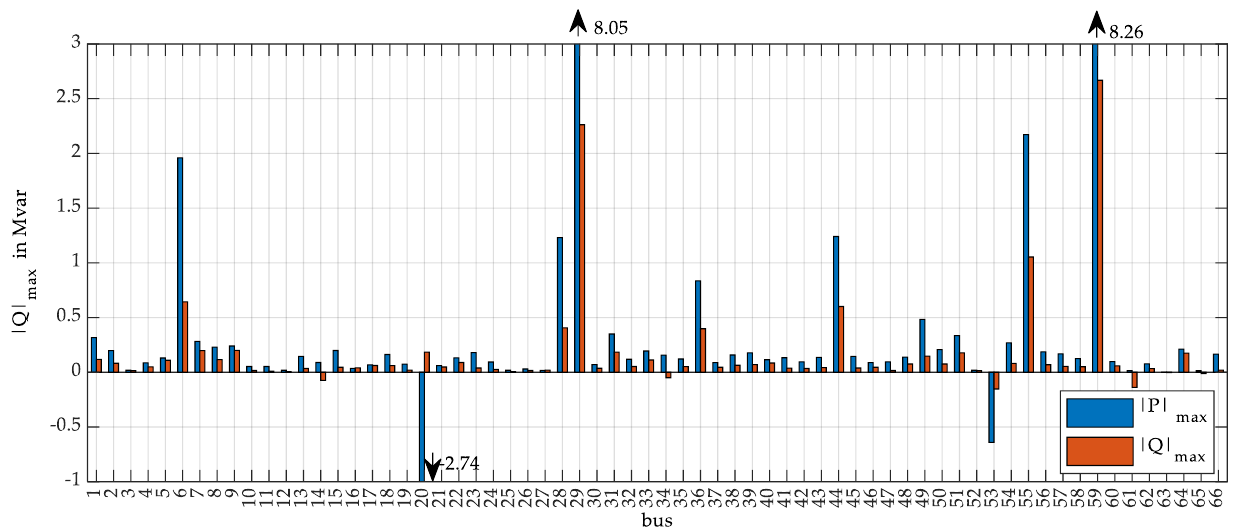
Figure 8. Maxima (absolute) active (blue) and reactive power behavior (orange) at load buses of the medium-voltage test system (non-simultaneous).